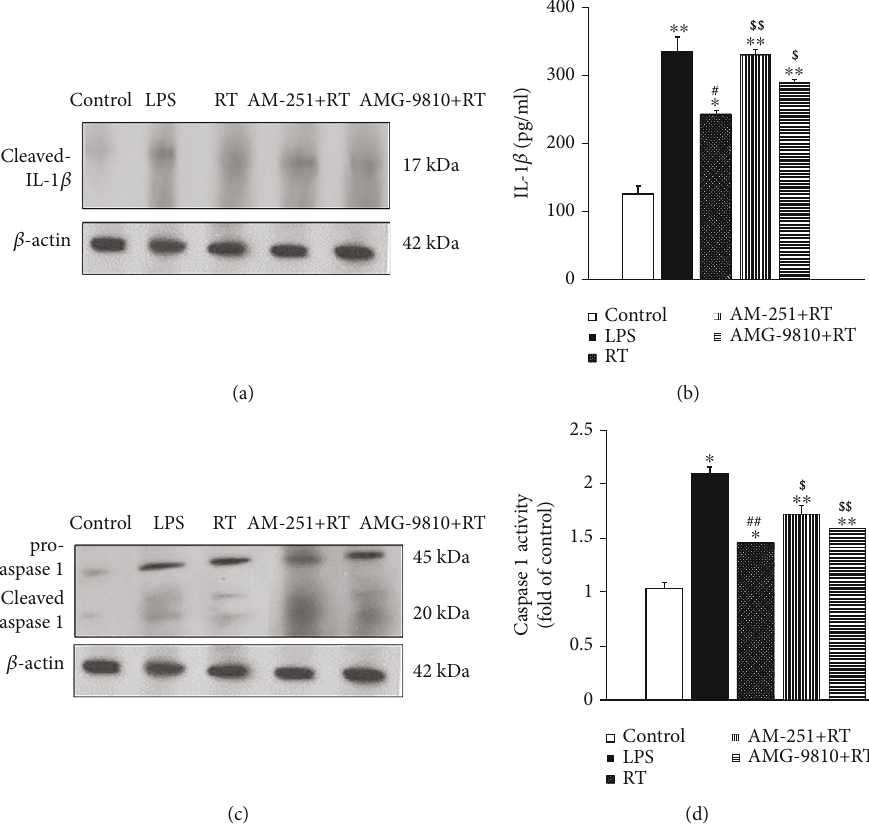
Figure 6: In fl uence of AM-251 and AMG-9810 on the (a) expression of cleaved IL-1 β , (b) IL-1 β secretion, (c) expression of cleaved caspase 1, and (d) activity of caspase 1 in LPS-stimulated AGS cells. All experiments were performed in triplicate, and the results were obtained from at least two independent experiments. Data are expressed as means ± SEM . ∗ Indicates signi fi cantly changes compared to control group, ∗ p < 0 : 05 , and ∗∗ p < 0 : 01 ; # compared to LPS group and ## p < 0 : 01 ; $ compared to RT group, $ p < 0 : 05 , and $$ p < 0 : 01